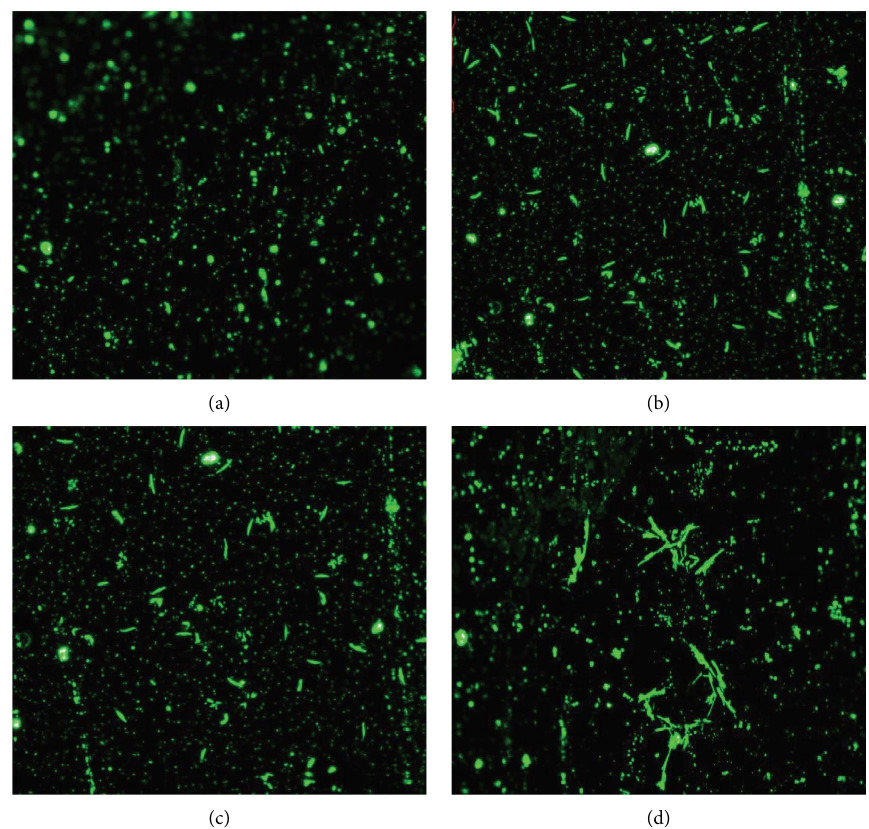
Figure 13: Fluorescent micrographs of asphalt and fbrous asphalt binder. (a) Asphalt binder. (b) Modifed corn straw fber asphalt.